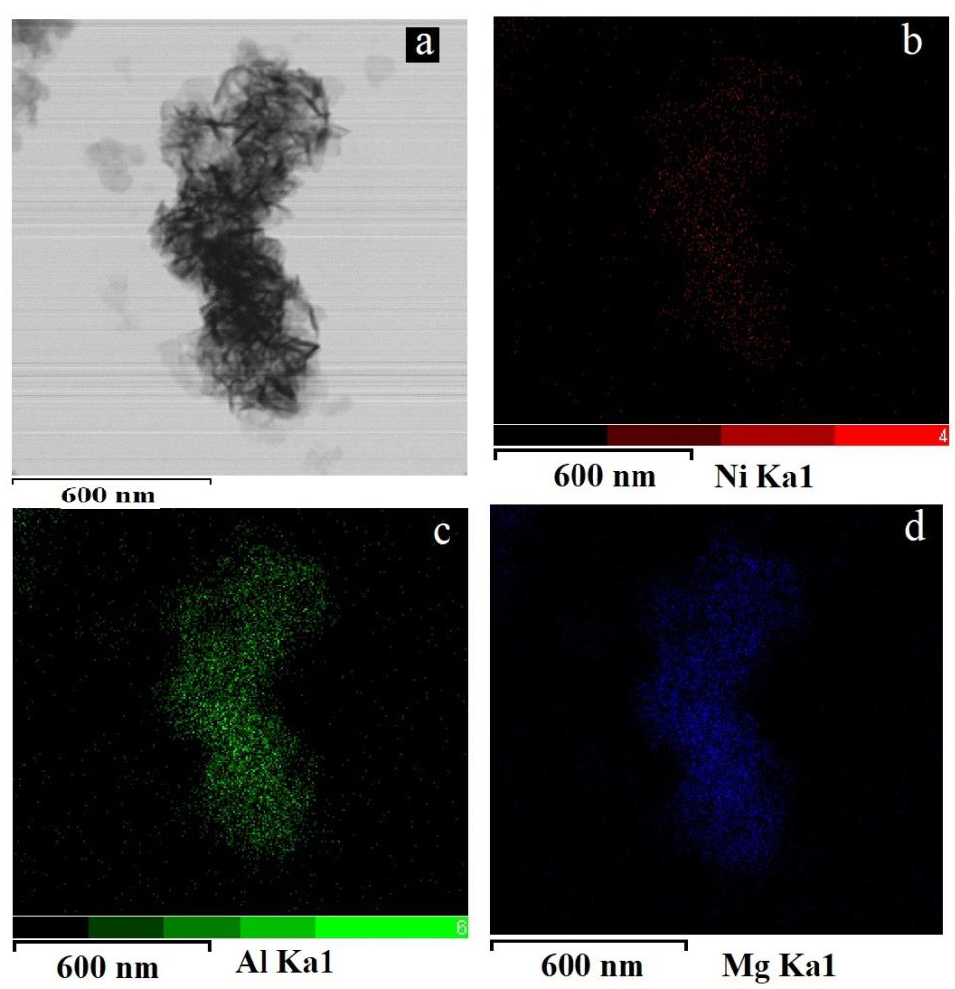
Figure 3. TEM mapping of Mg, Al and Ni for Mg/AlNi 25-ht sample: ( a ) TEM image, ( b ) nickel space distribution, ( c ) aluminum distribution, ( d ) magnesium distribution. Table 1. Elemental composition, crystal lattice parameters and textural characteristics of LDHs synthesized by different methods.